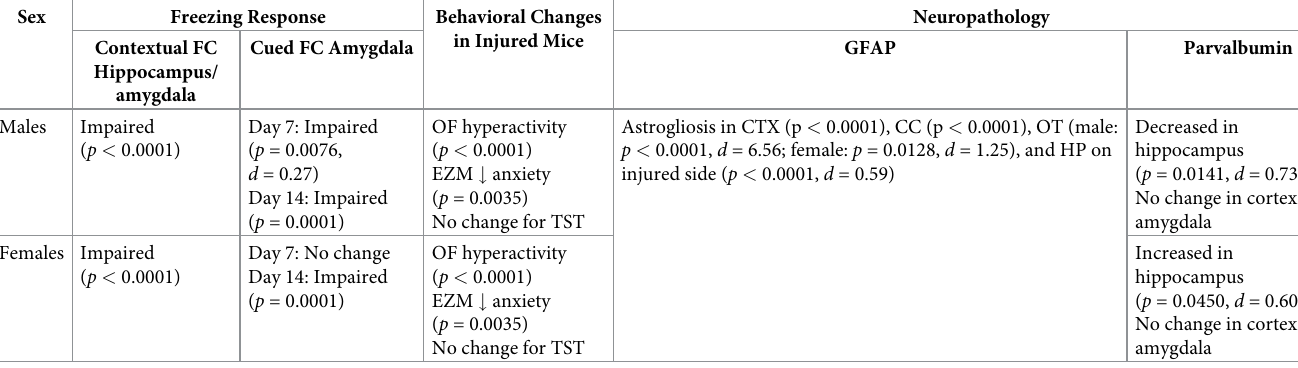
Table 2. Summary of the effects of rCBI on behavior and